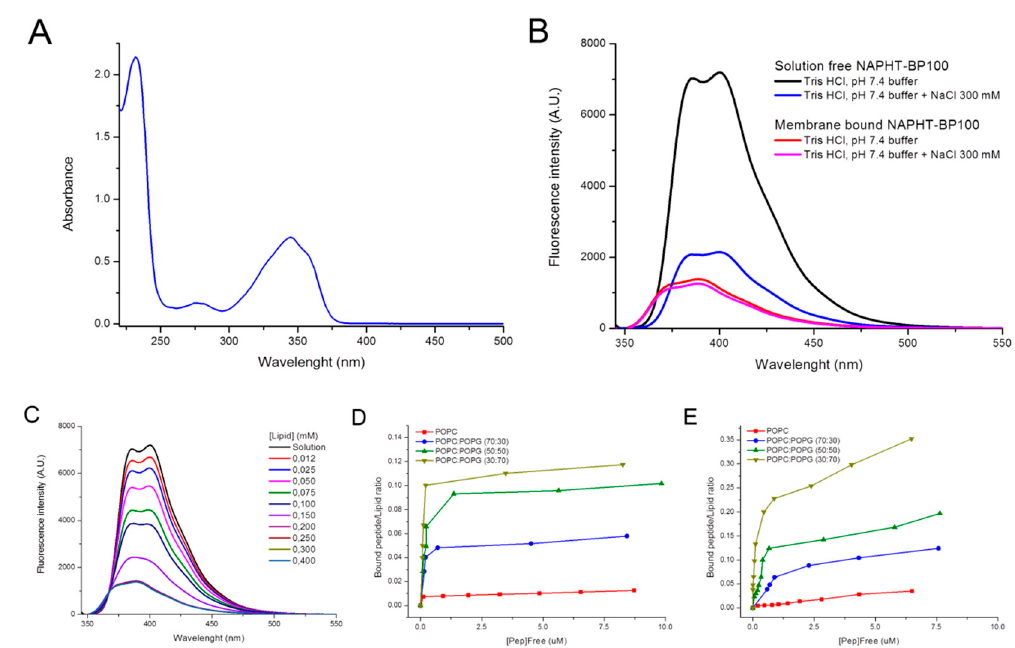
Figure 2. Analysis of NAPHT-BP100 UV absorption, fluorescence, and lipid binding. ( A ) NAPHT-BP100 UV absorption spectrum. Peptide concentration 55 µ M. ( B ) Fluorescence spectra of NAPHT-BP100 in solution and bound to POPC:POPG (50:50, molar ratio) large unilamellar vesicle (LUV) in 10 mM Tris-HCl buffer, pH 7.4 with or without 300 mM NaCl. ( C ) Fluorescence spectra of NAPHT-BP100 in solution and with POPC:POPG (50:50) LUV in 10 mM Tris-HCl buffer, pH 7.4. ( D ) Binding isotherms of NAPHT-BP100 to LUV in 10 mM Tris-HCl buffer, pH 7.4. ( E ) Binding isotherms of NAPHT-BP100 to LUV 10 mM Tris-HCl buffer, pH 7.4 with 300 mM NaCl. The peptide concentration was 20 µ M and temperature 25 ◦ C. λ Exc = 342 nm.